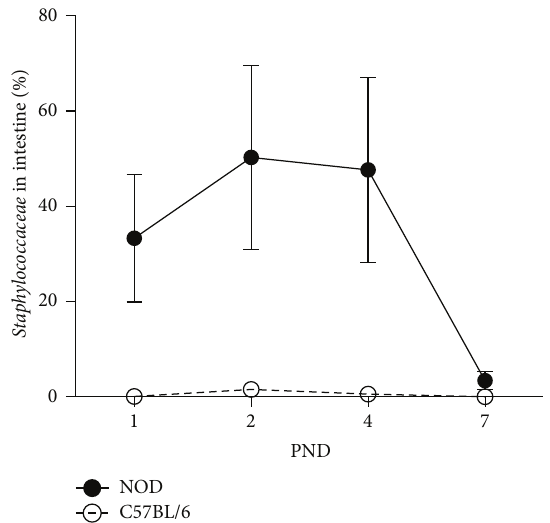
Figure 10: Microbiota composition of the intact intestine from C57BL/6 and NOD mice at PND 1, 2, and 4 as determined by 16S rRNA gene amplicon high throughput sequencing. Presence of Staphylococcus in the intestine of NOD and C57BL/6 mice. Data are expressed as percentage of bacteria present in intestine. Data are mean ± SEM ( 𝑛 = 4-5